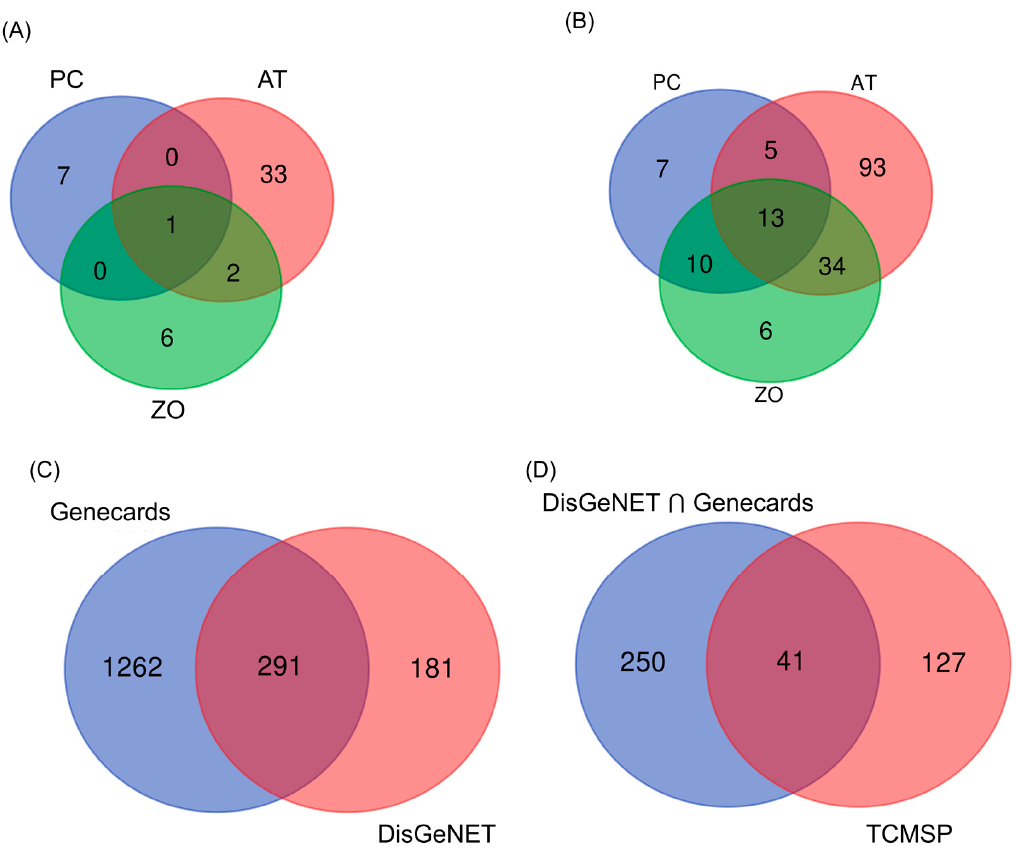
Figure 1. Venn diagrams of the compounds and target genes from the herbal combination. ( A ) Distribution of potential compounds from PC, AT, and ZO. ( B ) Target of potential form PC, AT, and ZO ( C ) Hyperlipidemia-related target genes from two web databases. ( D ) Dyslipidemia-related common target genes from both web databases and TCMSP.